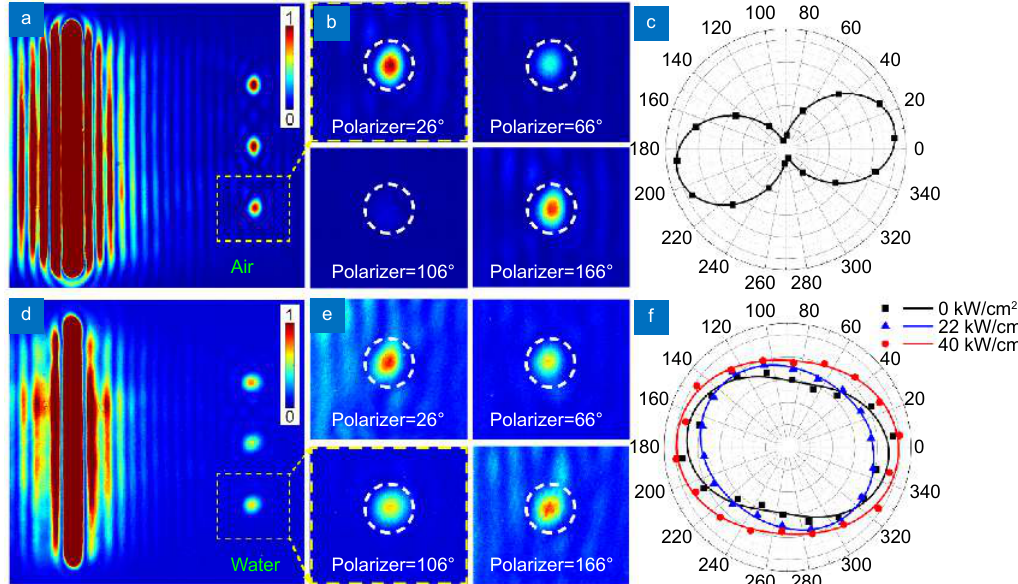
Fig. 5 | ( a ) Captured CMOS image of the sample in air. ( b ) CMOS images of the emission light from the plasmonic emitter [denoted by the yel- low dashed square in (a)] at different polarizer angles. ( c ) Polar plot of the measured intensities of the emission light from the plasmonic emitter in air by rotating the polarizer. ( d ) Captured CMOS image of the sample in water. ( e ) CMOS images of the emission light from the plasmonic emit- ter [yellow dashed box in (d)] at different polarizer angles. ( f ) Polar plot of the measured intensities of the emission light from the plasmonic emit- ter by rotating the polarizer at different pump